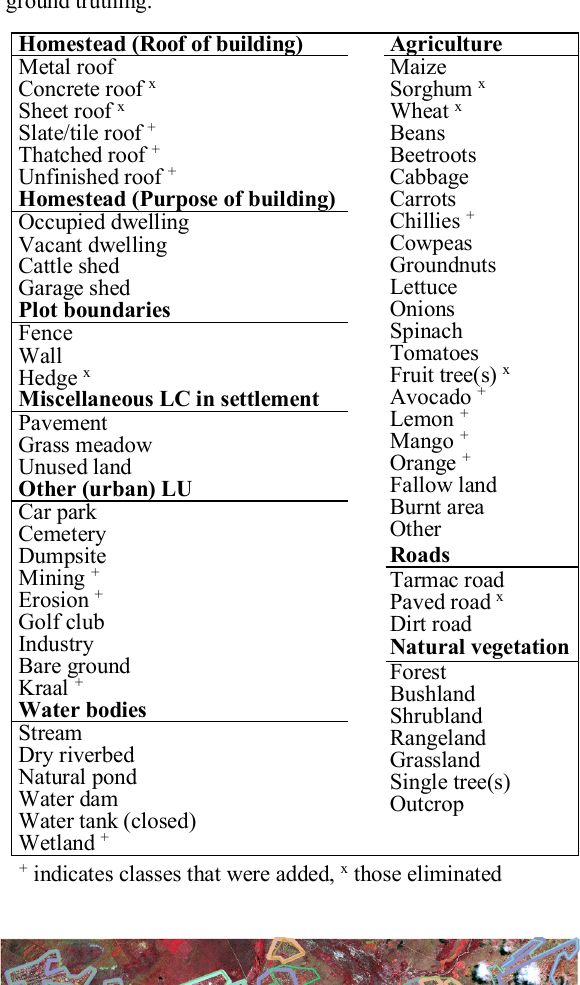
Table 2: Hierarchical LUC classification scheme, updated post ground truthing.